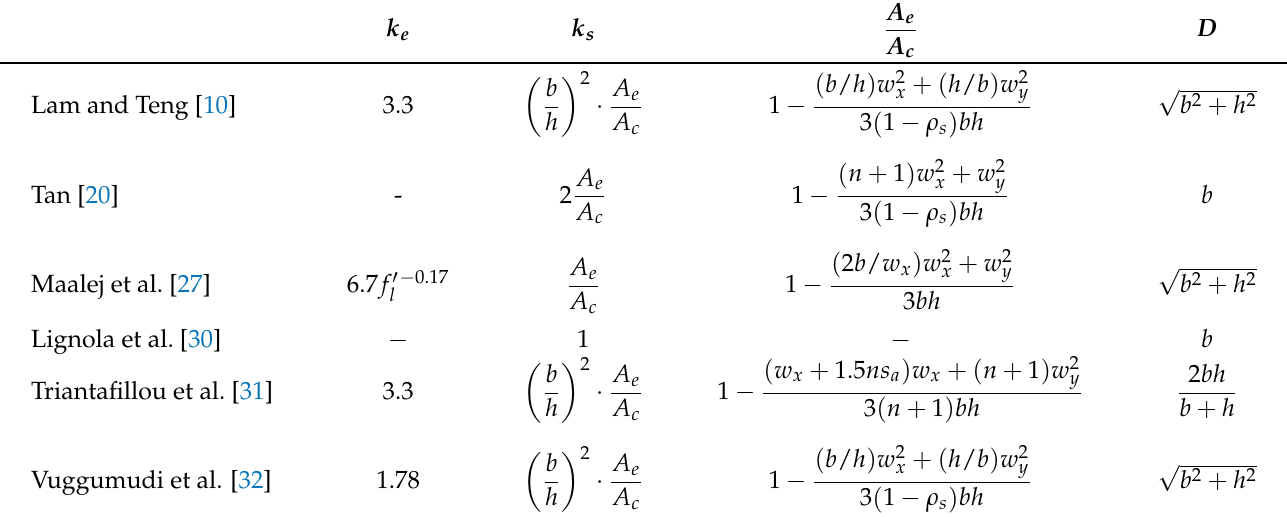
Table 1. Parameters of the confined concrete analytical models in wall-like cross-sections k